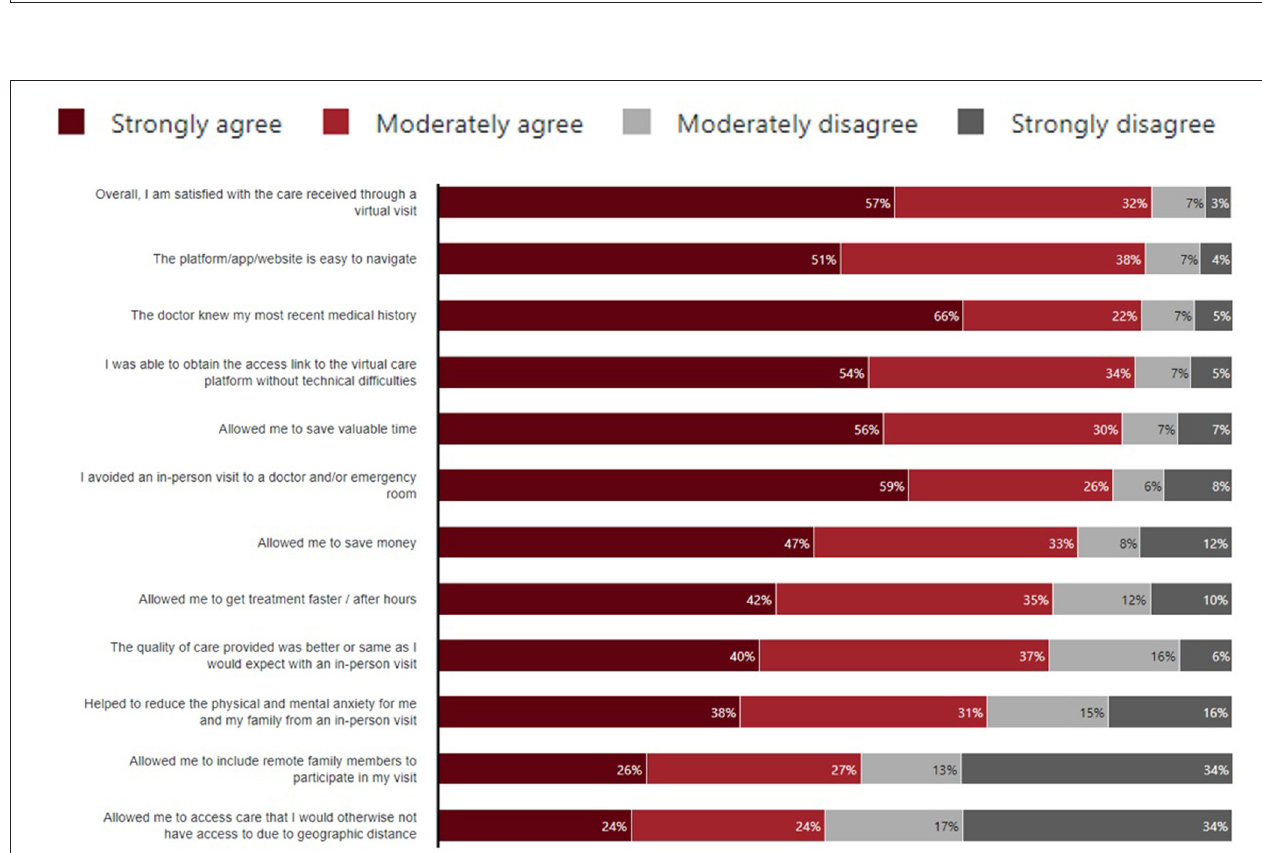
Frontiers in Public Health |